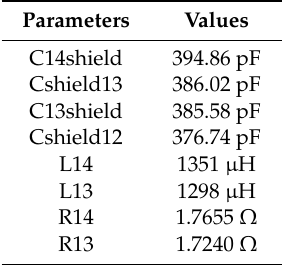
Table 8. Modified RLC parameters of HV winding with shield placement between layer 14 and layer13 and between layer 13 and layer